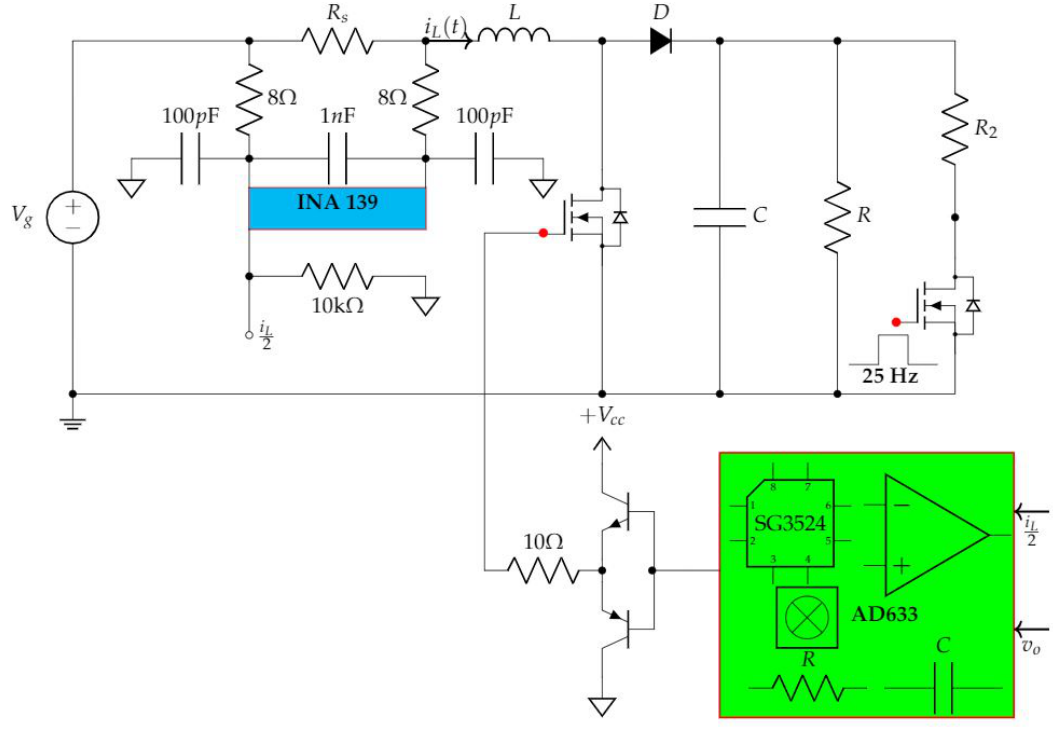
Figure 10. Circuit diagram of a boost converter with the proposed LMI-Fuzzy